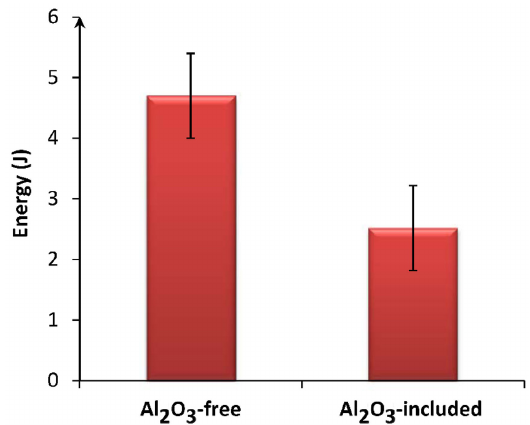
Figure 11. Fracture surface of impact test specimens: (a) Al